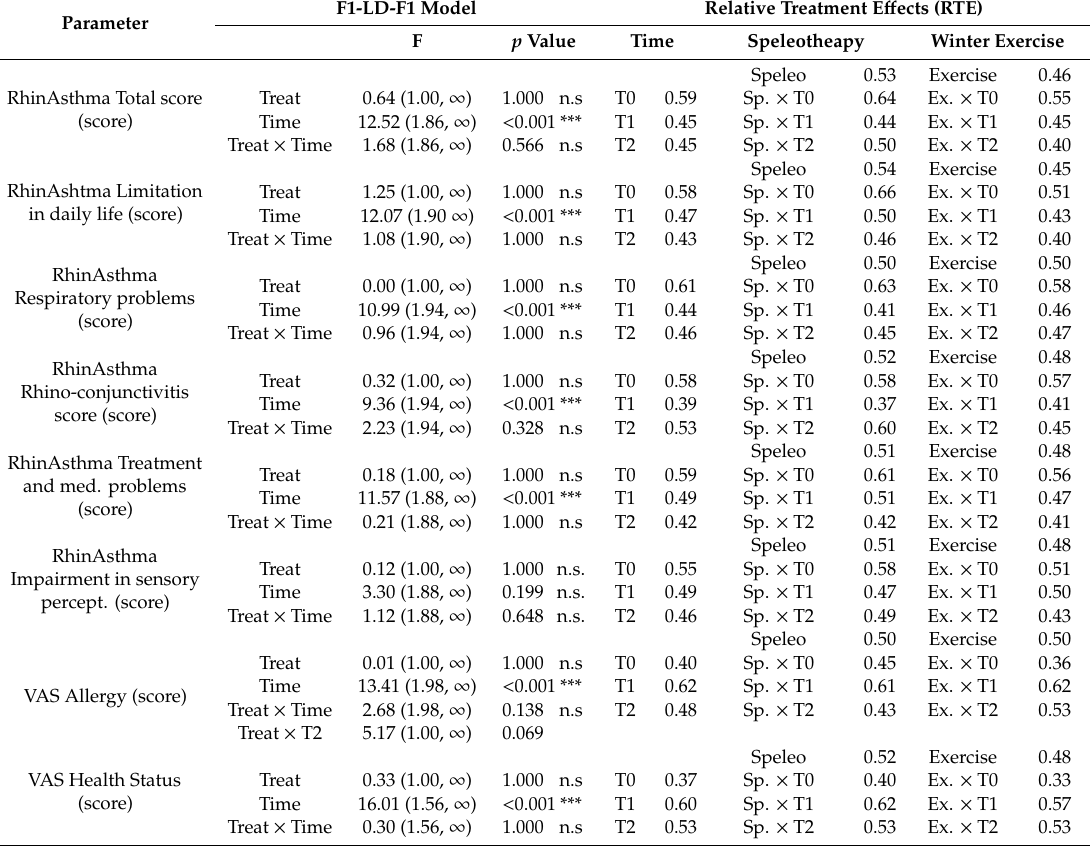
Table 5. Results from the F1-LD-F1 model reporting time, treatment, and interaction e ff